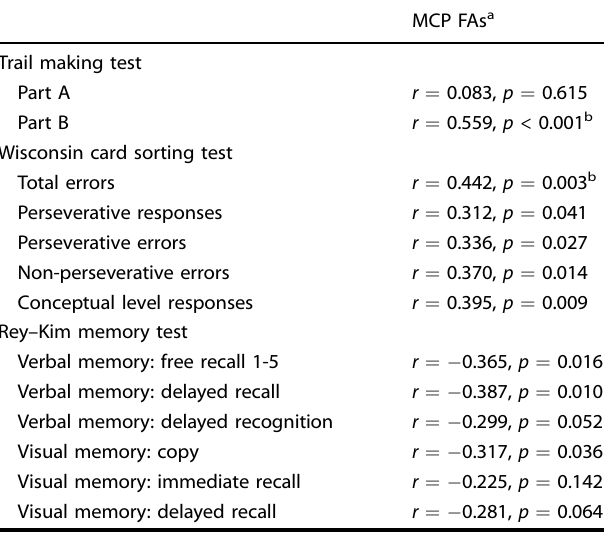
Fig. 2 Between-group comparison of cerebro-cerebellar white matter connectivity and relationship between MCP FAs and cognitive performance in participants with schizophrenia. a Participants with schizophrenia showed signi fi cantly lower FAs in a cluster located in the middle cerebellar peduncle compared to healthy controls (TFCE-corrected p < 0.05). b Higher MCP FAs were associated with a longer time taken to complete the TMT-B and more total errors in the WCST in participants with schizophrenia ( n = 46). Table 3. Correlations between FAs in the MCP cluster and cognitive performance in participants with schizophrenia ( n =